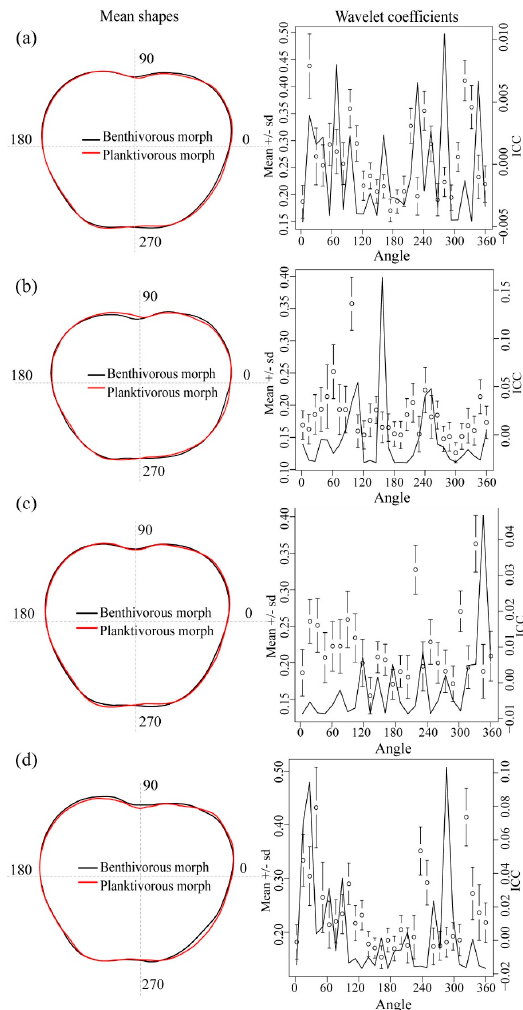
Figure 5. Red and black contours indicate mean otolith shapes, based on wavelet reconstruction for planktivorous and benthivorous morphs of Schizopygopsis thermalis . Line chart signifies means and standard deviations of the wavelet coefficients (black circles) which represent the mean shape of all otoliths, and the magnitude of variation in S. thermalis (the intraclass correlation coefficient, black line). Both x-axes show angles in degrees ( ◦ ) based upon polar coordinates, where the centroid of the otolith is the center point of the polar coordinates. ( a – d ) denote the combination of all TL groups, first TL group, second TL group, and third TL group,